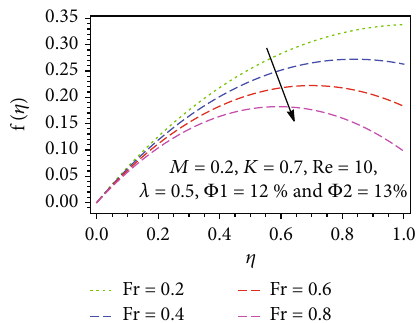
Figure 2: Impact of local inertial parameter Fr over momentum pro fi le f ð η Þ